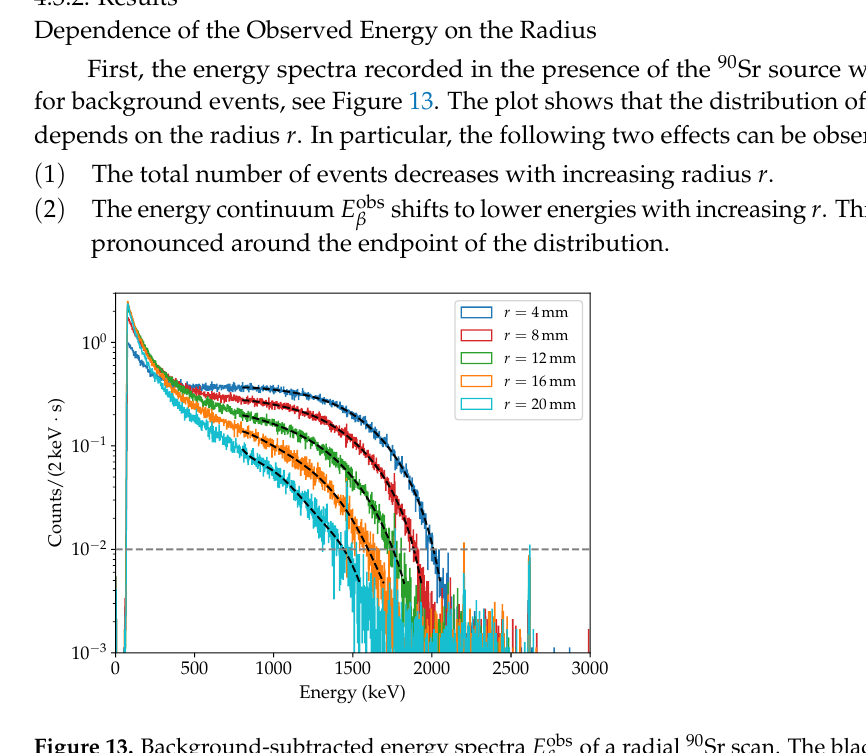
of a radial 90 Sr scan. The black dashed lines β